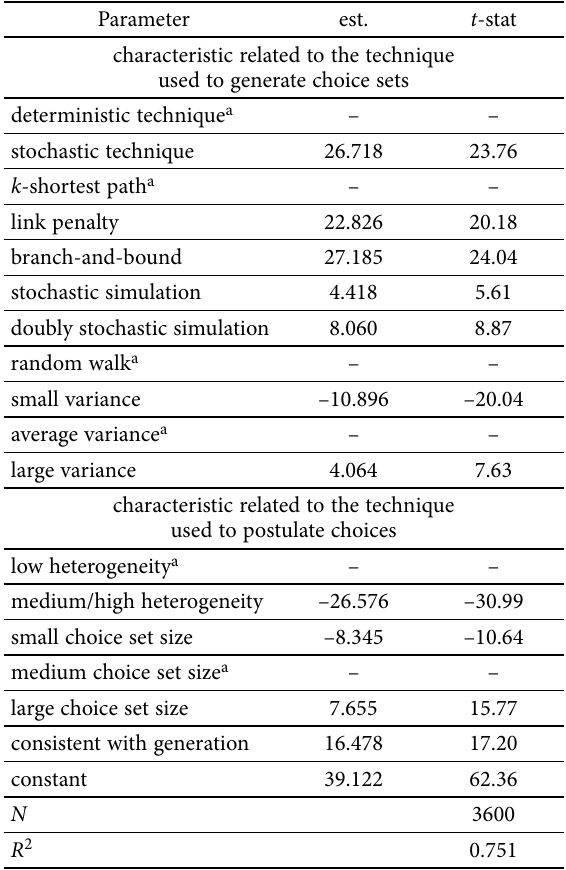
Table 4. Meta-analysis estimates of the coverage